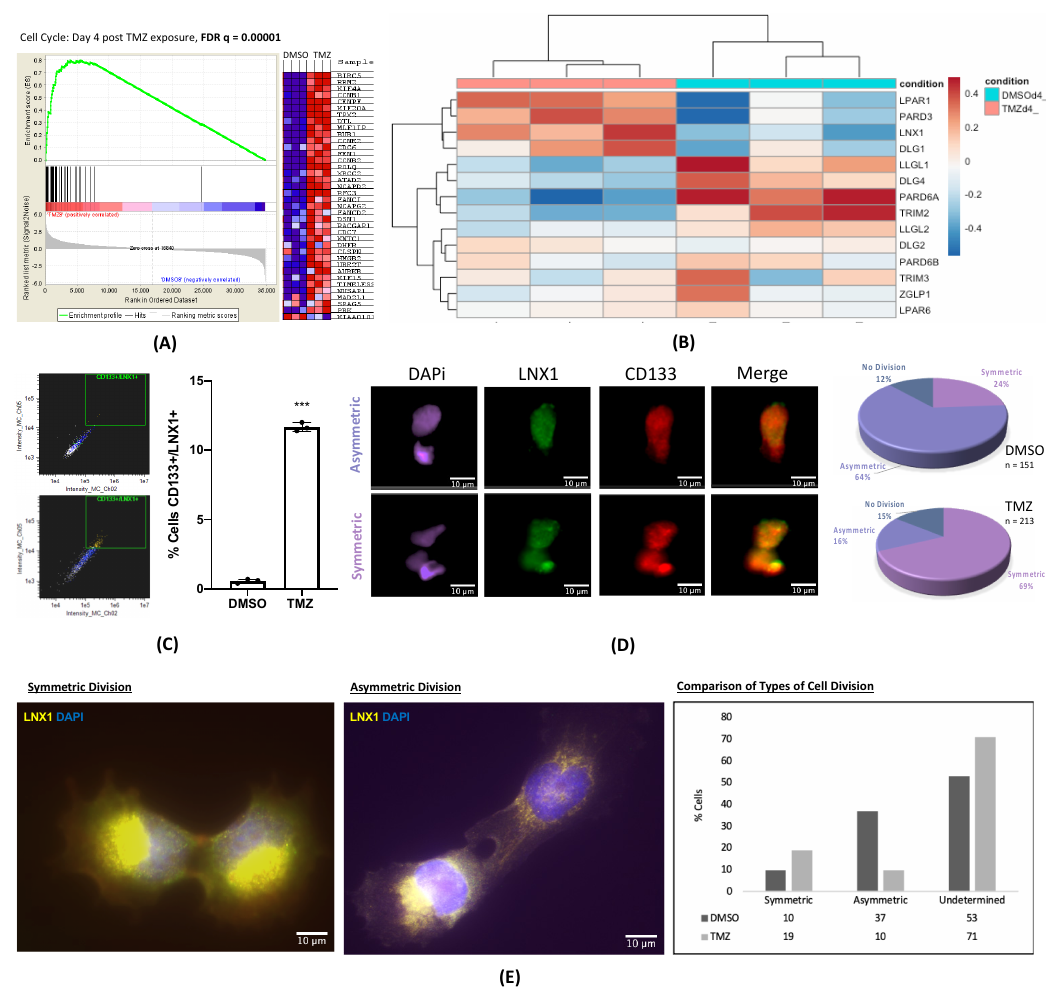
Figure 1. Polarized LNX1 Expression during temozolomide (TMZ) therapy. ( A ) Gene set expression analysis (GSEA) analysis comparing GBM43 cells treated for 4 days with dimethyl sulfoxide (DMSO) or 50 µM TMZ showed significant enrichment of cell division and stemness pathways. ( B ) RNA-Seq analysis of a panel of genes involved in polarized cell division in GBM43 cells treated with DMSO vs. 50 µM TMZ showed significant enrichment of LNX1 expression after TMZ therapy. ( C ) Analysis of GBM6 cells by ImageStreamX technology revealed that expression of LNX1/CD133 significantly increased after TMZ therapy. ( D ) Image analysis showed that LNX1 and CD133 reliably colocalize and that TMZ therapy significantly increases the percentage of symmetric stem cell divisions as compared to DMSO. ( E ) U251 cells were analyzed manually in an experiment comparing dividing cells treated with DMSO vs. 50 µM TMZ. Similar results to prior were observed, where TMZ significantly increased the proportion of symmetrically dividing stem cells as compared to control. Data were analyzed using ImageStreamX software or Prism 8, as appropriate. Student’s t-test was used to calculate significance between 2 groups. Analysis of variance (ANOVA) was used for greater than 2 groups.; *** p < 0.001; ns, not significant.